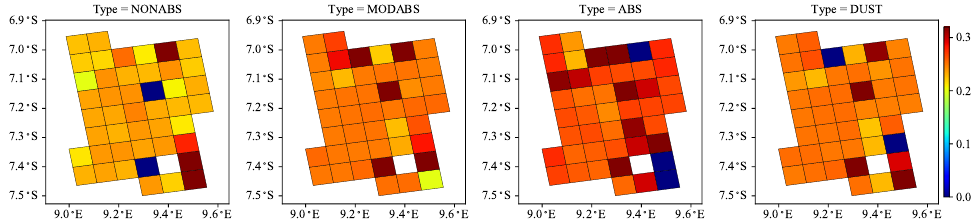
Figure 9. ( a ) The aerosol model with the highest evidence from Set 1, and ( b ) the aerosol type containing the aerosol model with the highest evidence from Set 2. The TROPOMI spectra were recorded on 4 July 2019.